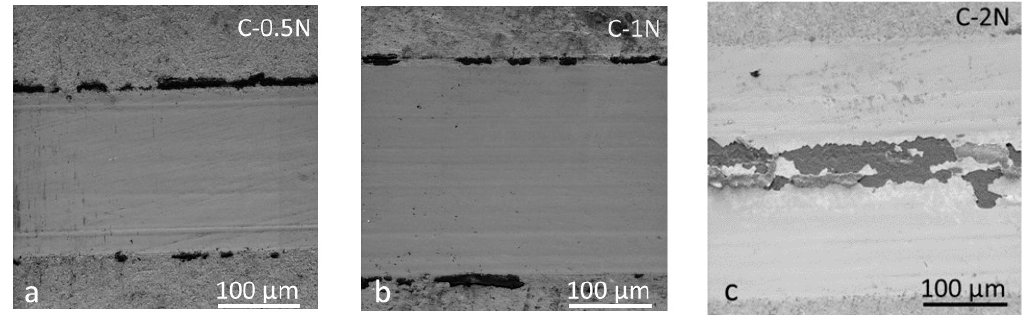
Figure 13. SEM images of the wear track corresponding to ( a ) 0.5 N, ( b ) 1 N, and ( c ) 2 N tribocorrosion tests.